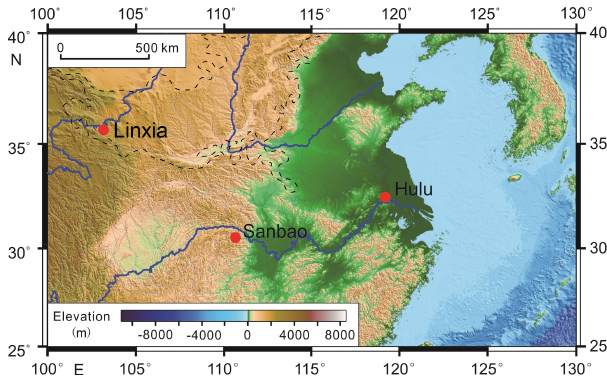
Figure 1. The location of the Linxia loess profile and Sanbao–Hulu cave records. The Linxia profile, located on the edge of convergence zone of the alpine Qinghai–Tibet Plateau, with the northwest be- ing arid and the southeast being monsoon area, is very sensitive to the migration of desert regions and monsoonal rainfall. Sanbao– Hulu cave is located in the monsoon-influenced Yangtze River val- ley, sensitive to monsoon-induced precipitation changes. The black dashed line represents the scope of Chinese Loess Plateau. The base map is drawn using GMT software, and the elevation data are from http://www.ngdc.noaa.gov/mgg/global/global.html (last access: 14 June